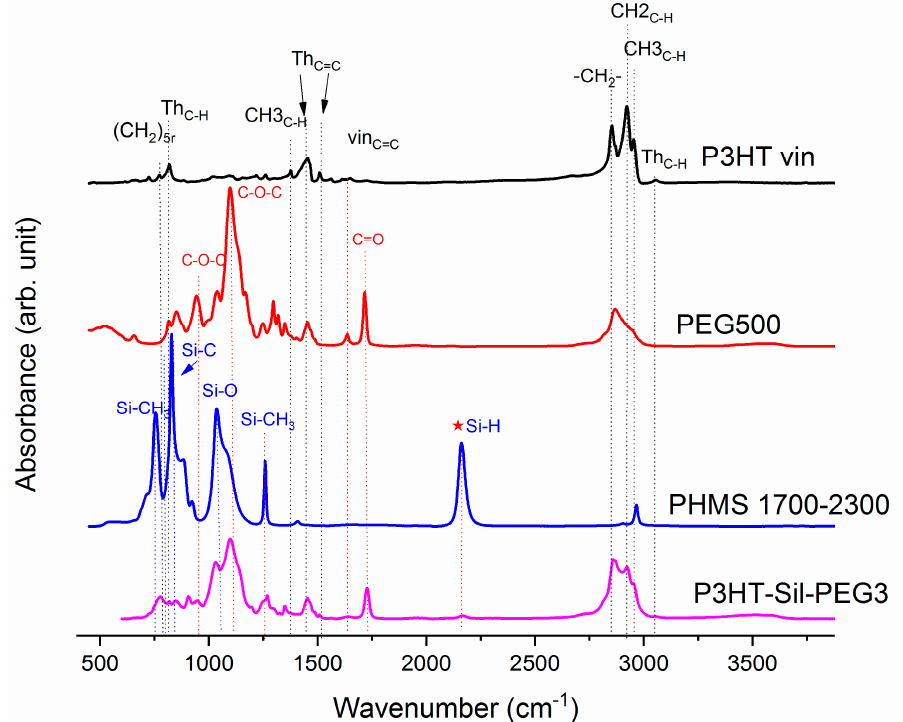
Figure A7. IR-ATR spectrum of poly(methylsiloxane)-graft-[poly(3-hexylthiophene); poly(ethylene glycol)] (chloroform fraction of vinyl terminated poly(3-hexylthiophene) ( P3HT-Sil-PEG3 ); poly(methylhydrosiloxane) trimethylsilyl terminated PMHMS 1700–2300; poly(ethylene glycol) methyl ether methacrylate PEG 500.